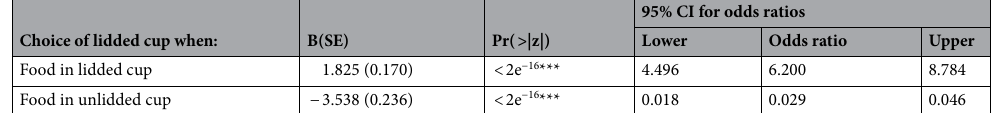
Table 5. Logistic regression model output for subjects’ preference of the lidded cup when it contained food, compared to when it was empty and the food was presented in the unlidded cup. *** p < 0.001.